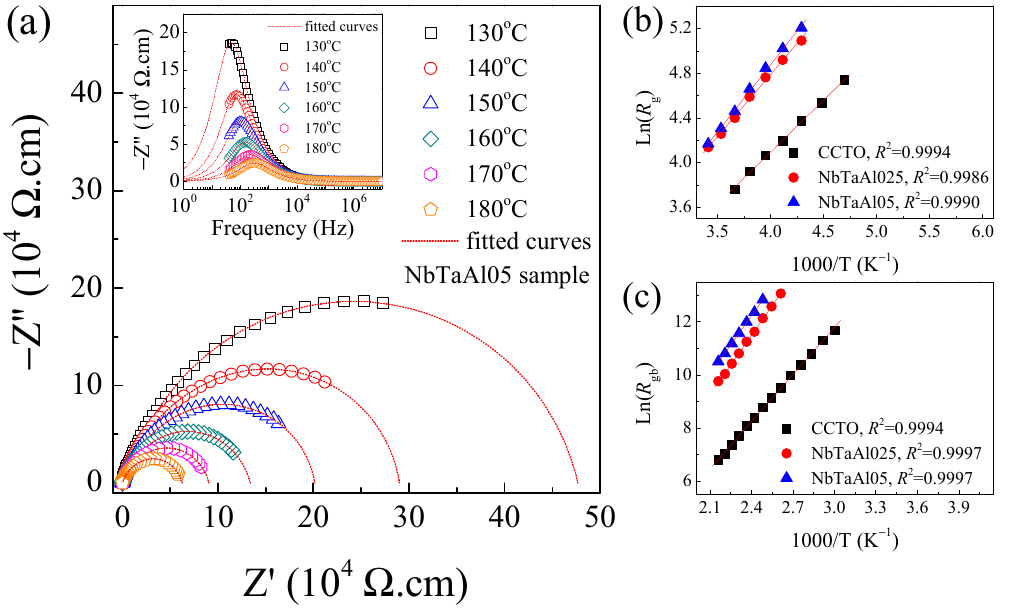
Figure 7. ( a ). Impedance complex Z* plots in a temperature range of 130–180 °C of the NbTaAl05 ceramic; its inset shows the frequency dependence of Z ″ in the same temperature range. ( b ) Arrhenius plot of R g and ( c ) Arrhenius plot of R gb .